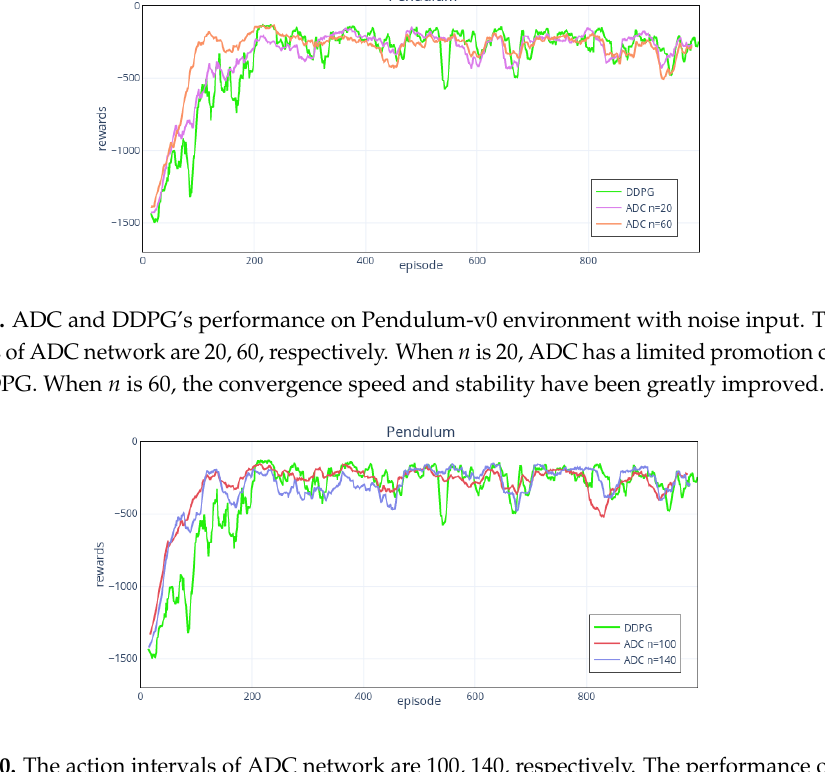
Figure 10. The action intervals of ADC network are 100, 140, respectively. The performance of the two groups are similar, both better than DDPG. The stability of 100 intervals is slightly better than